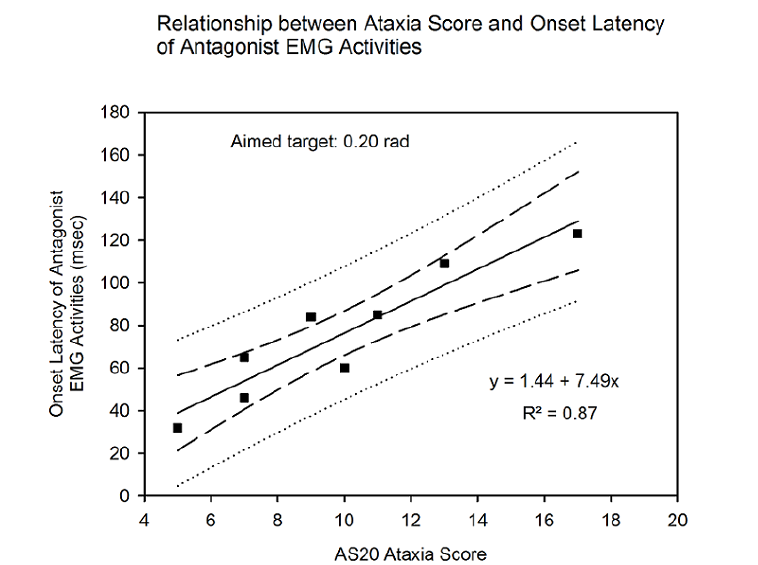
Figure 3. Relationship between the ataxia rating score and the onset latency of the antagonist EMG activities for fast pointing movements (FPM) (aimed target: 0.2 rad; basal mechanical state of the hand). Long dash: 95% confidence intervals; dotted lines: 95% prediction